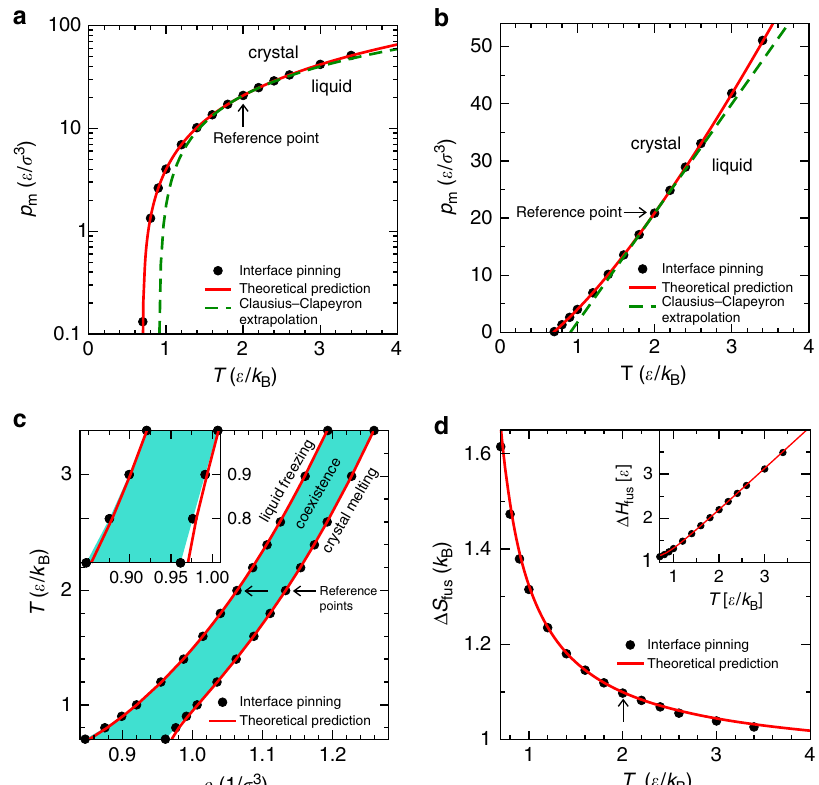
Figure 3 | Theoretical predictions (full red curves) and results of MD simulations (black dots) for the LJ system. The theoretical predictions are based on simulations at the coexistence reference state point indicated by an arrow in each figure ( T 0 ¼ 2.0 e / k B ), the MD simulations employed the interface-pinning method 37 , see the ‘Methods’ section. No fitting was done in these figures—the only input to the theory is properties of the coexisting liquid and crystal at the reference temperature. ( a ) Temperature–pressure phase diagram. The green dashed line marks the expectation based on a linear extrapolation of the Clausius–Clapeyron relation d p m /d T ¼ D S fus / D V fus from the reference state point, that is, assuming that the entropy of fusion and the volume change are both constant. ( b ) The same data plotted with a linear pressure axis. ( c ) The freezing and melting lines in the density–temperature phase diagram; the coloured area is the coexistence region. ( d ) Fusion entropy (main panel) and enthalpy